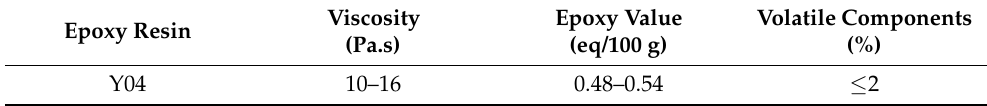
Table 2. Resin system’s main